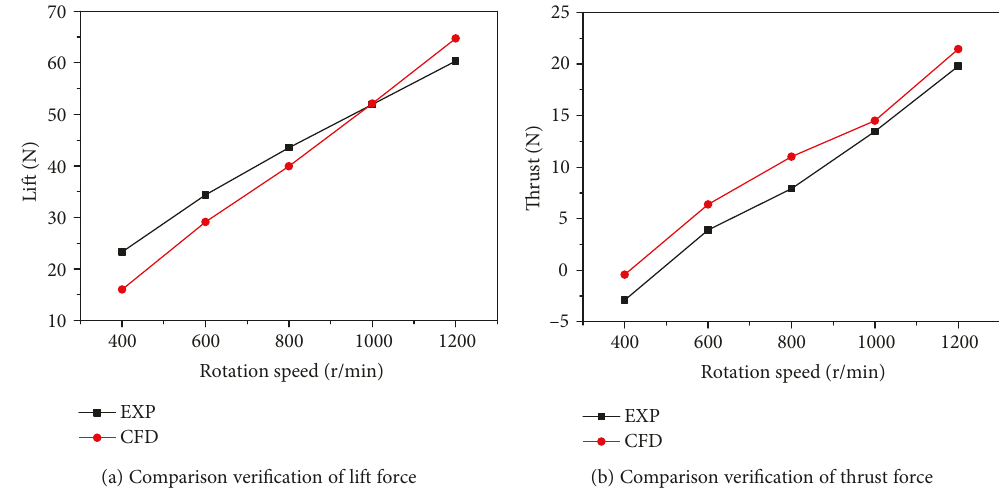
Figure 4: The numerical calculation results and test results with the cross fl ow fan speed change curve.